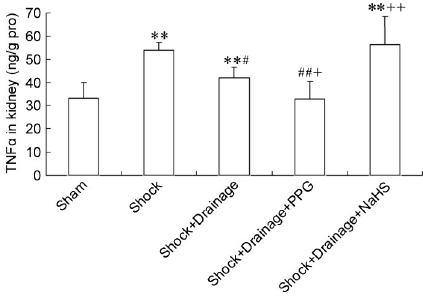
Figure 5. Changes in Toll-like receptor 4 (TLR4) levels in the renal homogenates of rats. Data are reported as means±SD (ng/g protein, n=6). PPG: D,L-propargylglycine; NaHS: sodium hydro- sulfide hydrate. *P , 0.05, **P , 0.01 vs the sham group; ## P , 0.01 vs the shock group; ++ P , 0.01 vs theshock++drainagegroup (one- way ANOVA).